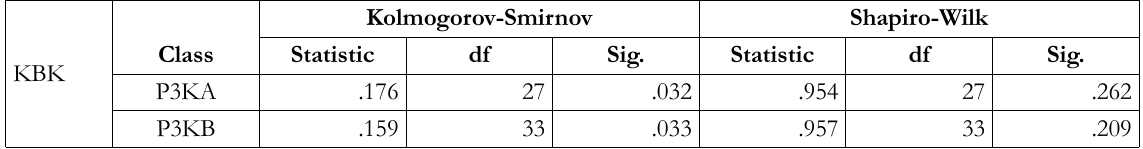
Table 6. Results of data normality test on critical thinking skills of chemistry